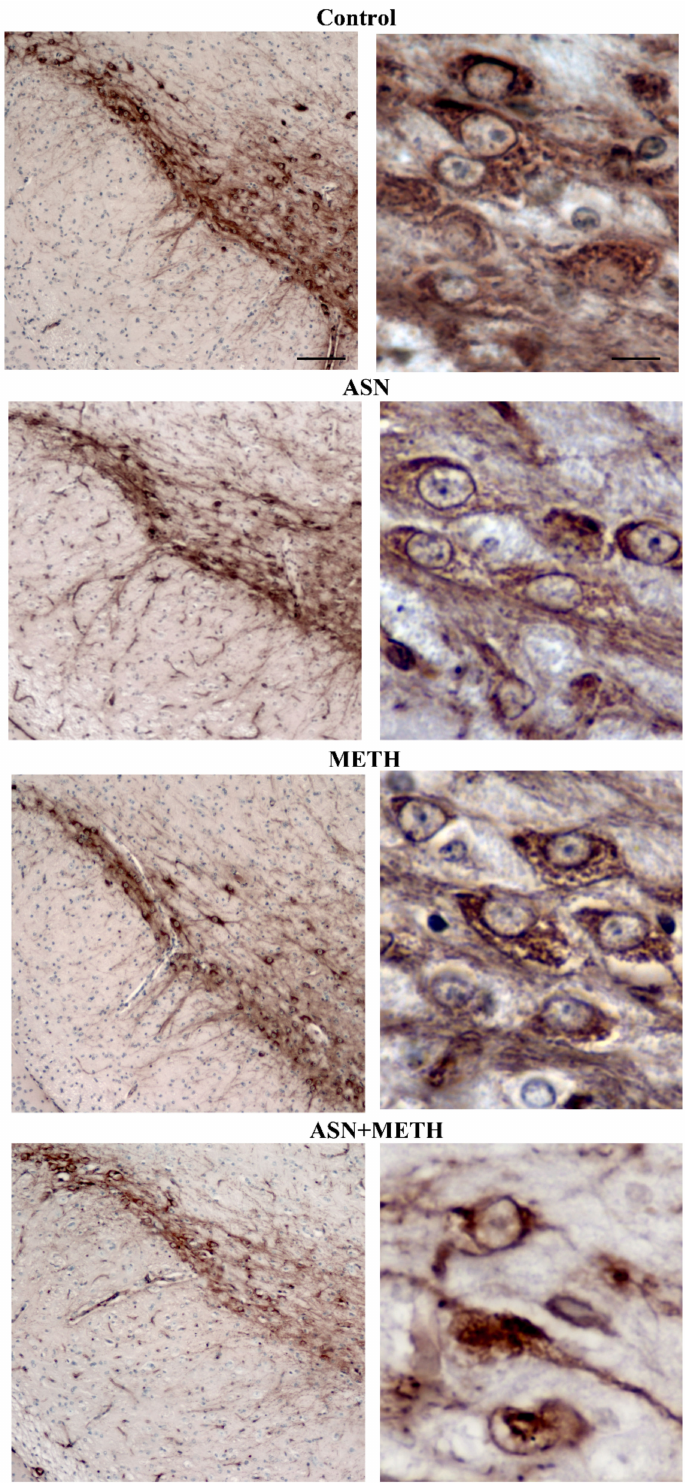
Figure 8. Representative pictures of TH-immunopositive cell bodies within SNpc. Combined treatment with ASN and METH alters the cell body of TH-immunopositive neurons within SNpc. Scale bar (low magnification) = 100 µ m; scale bar (high magnification) = 12 µ